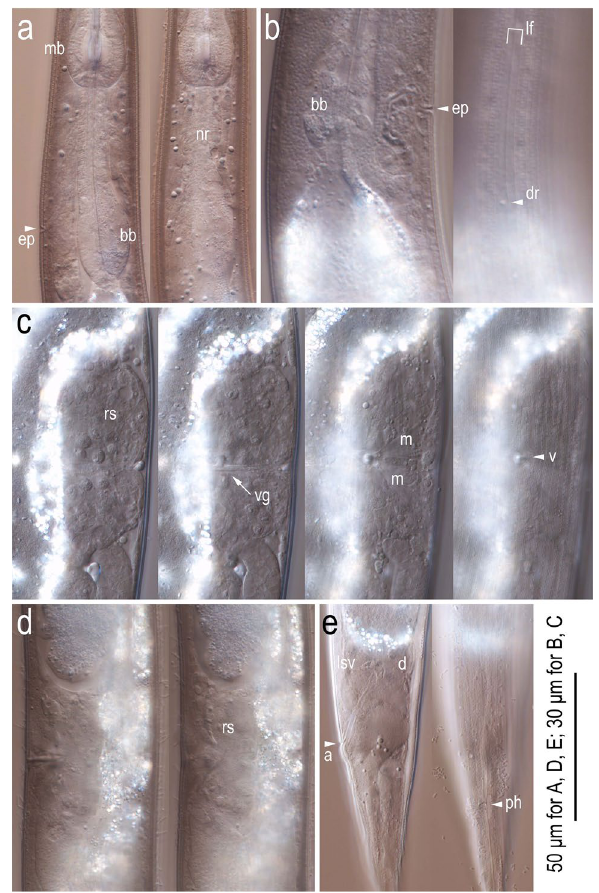
Figure 6. Light micrographs of anterior region and female characters of Onthodiplogaster japonica n. gen., n. sp. ( a ) Left lateral view of metacorpus to posterior pharynx region in two different focal planes; ( b ) right lateral view of basal bulb region in two different focal planes; ( c ) ventral view of vulval region in four different focal planes; ( d ) left lateral view of vulval region in two different focal planes; ( e ) left lateral view of anal region in two different focal planes. Labels are as follows: a = anus; bb = basal bulb; d = dorsal anal gland; dr = deirid; ep = secretory-excretory pore; lf = lateral field; lsv = left subventral anal gland; m = vulval muscle; mb = median bulb (metacorpus); ph = phasmid; rs = receptaculum seminis ; v = vulva; vg =